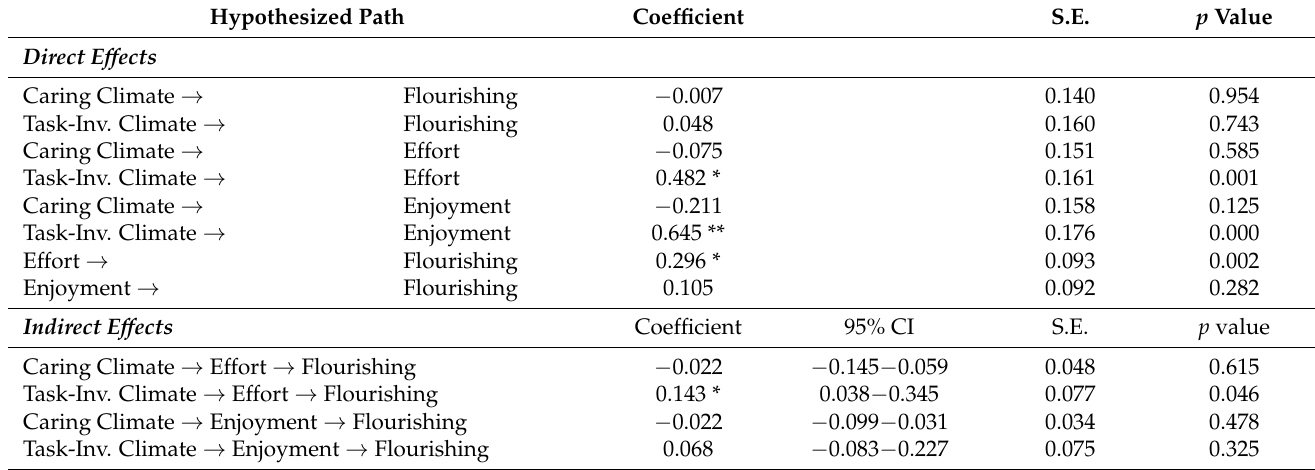
Figure 2. Mediation Analyses: Model 1. Note: Model fit (CFI = 0.93, TLI = 0.92, RMSEA = 0.06, and SRMR = 0.05). Significant theory-driven regression paths (* p ≤ 0.05; ** p ≤ 0.001) are presented in the model. Standardized regression coefficients are presented for each significant path. The significant indirect effect was as follows: Task-Involving Climate → Effort → Flourishing (0.14). Table 3. Model 1 parameter estimates, standard error, and p values.